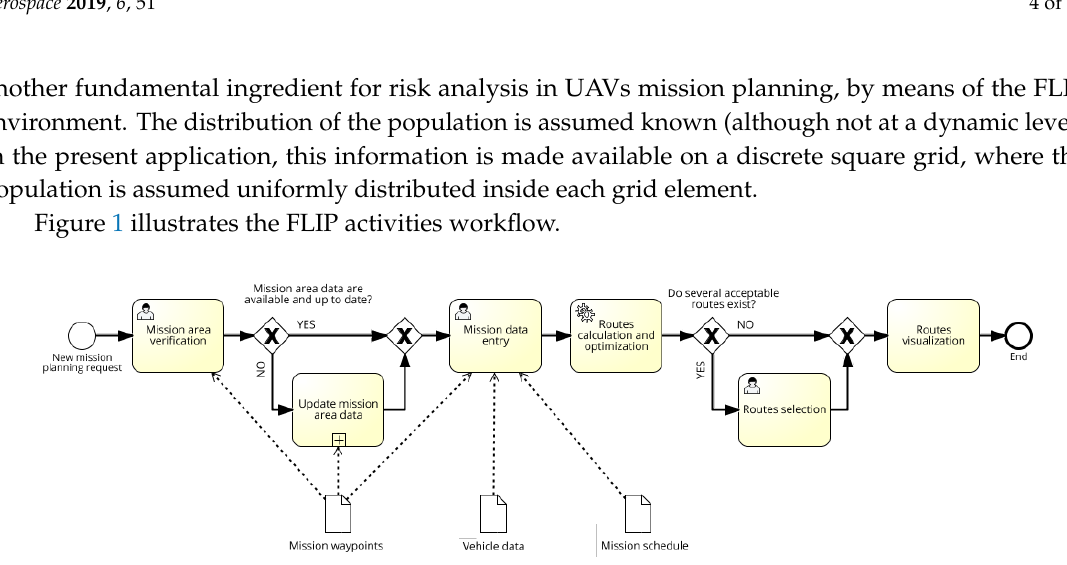
Figure 1. Flight planner (FLIP) process.